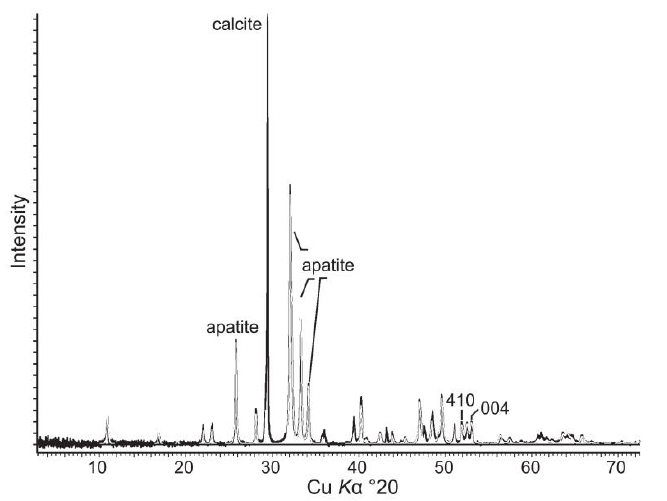
Figure 9. X-ray diffraction pattern of Sphenothallus sp. from the Upper Ordovician of Estonia [14].